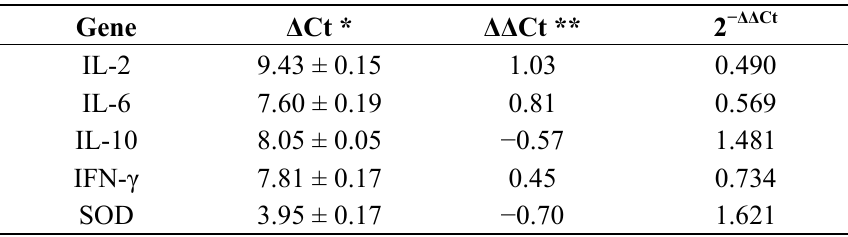
Table 1. Effects of PB3 on the expression of target genes (n =